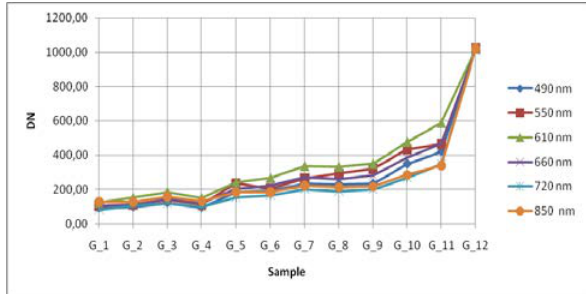
Figure 9. Spectral characteristics acquired from minMCA images